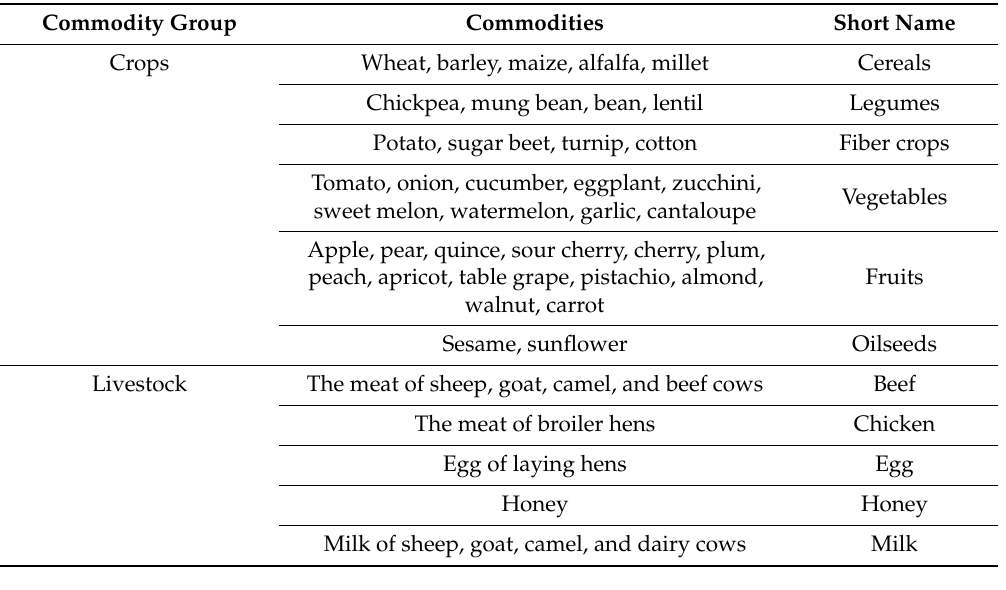
Table 1. Agricultural commodities included in this